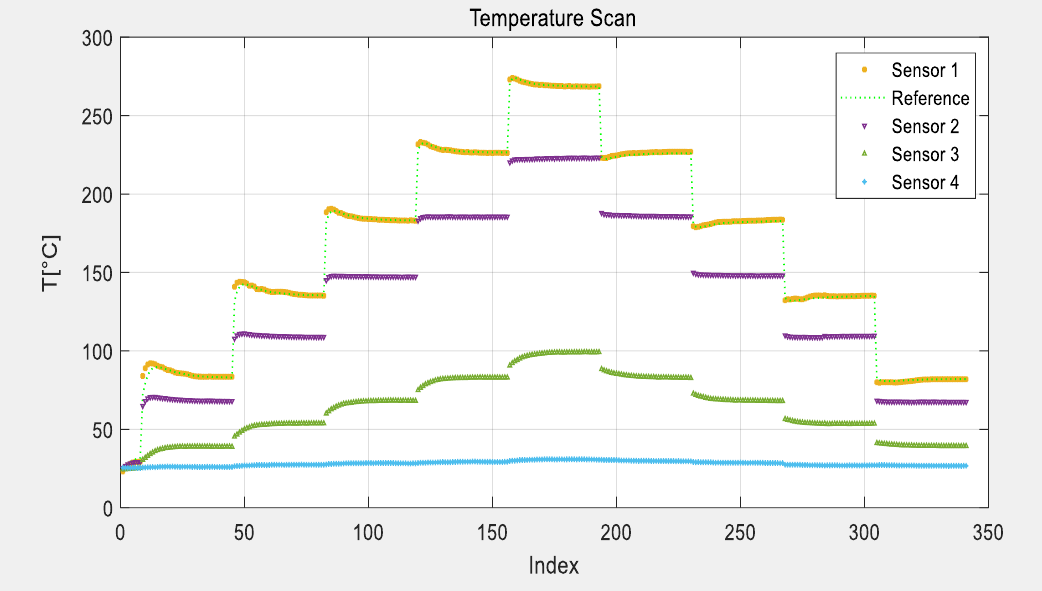
Figure 7. Temperature scans with four SAW sensors at different temperatures inside a furnace.